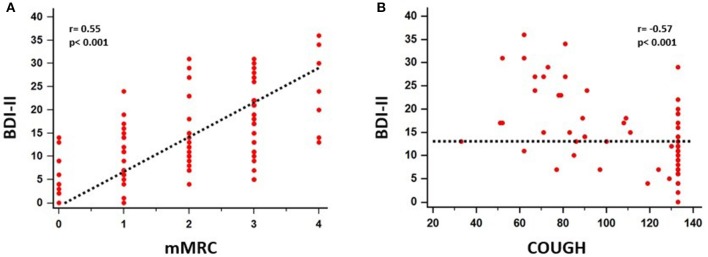
Significant association between depressive symptoms and mMRC (r = 0.55, p < 0.001) (A), cough (r = −0.57, p < 0.001) (B) was identified.